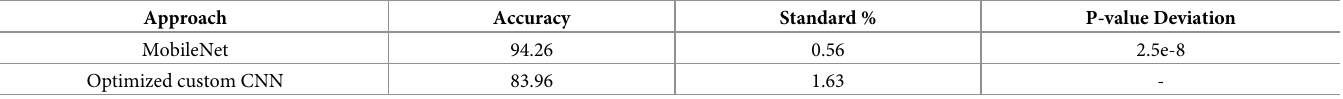
Table 4. Accuracy, standard deviation and p-values. The accuracy is the average across the 20 runs with different random data partitions. P-values are calculated using the optimized custom CNN as